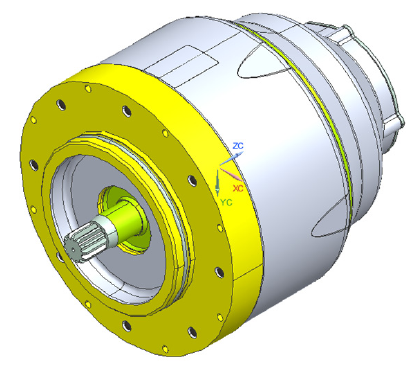
Figure 6. Electric Motor used in this study.